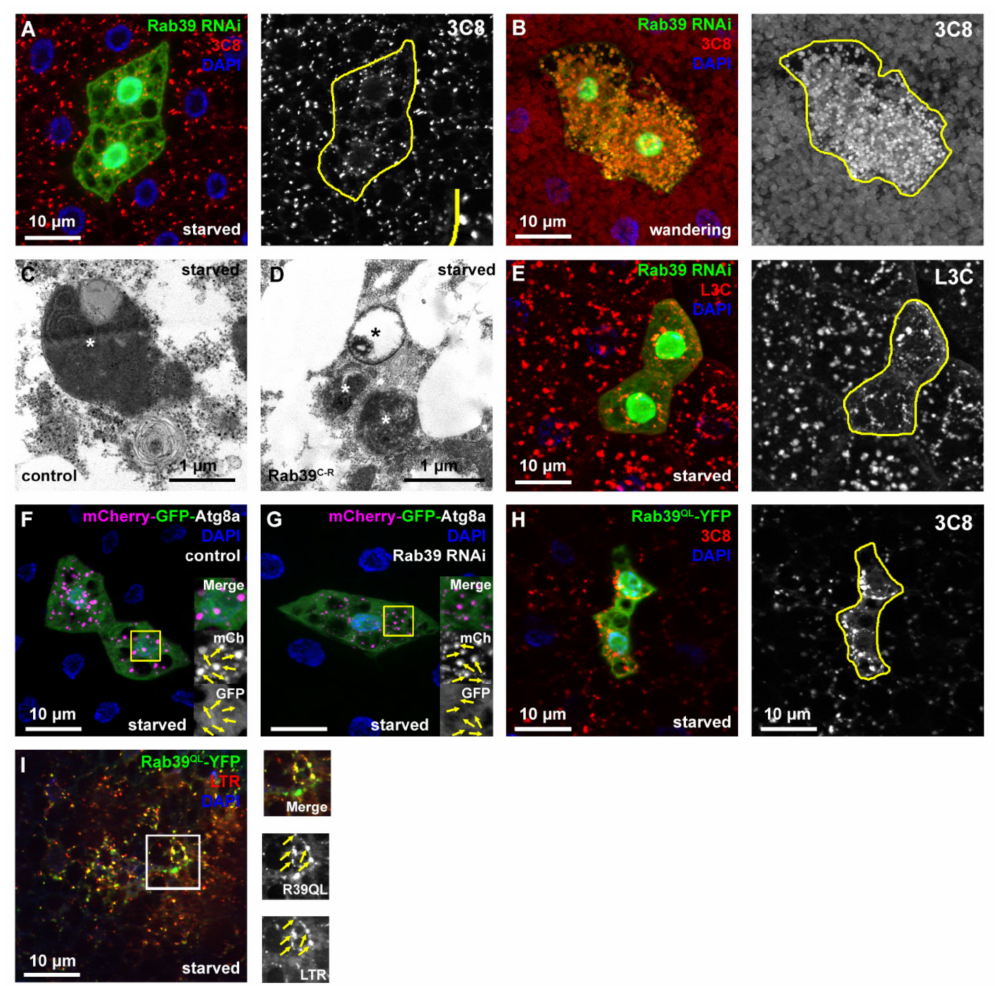
Figure 4. Rab39 accelerates autophagic degradation in fat cells. ( A , B ) 3xmCherry-Atg8a was expressed in all fat cells in starved ( A ) or wandering ( B ) L3 stage animals. In the GFP-positive cells, Rab39 was silenced with RNAi (marked with yellow line in the grayscale panels). In both cases, 3xmCherry-Atg8a dots were smaller in the GFP-positive cells compared to the adjacent control cells. ( A ) An inset shows the size difference of 3xmCherry-Atg8 dots. ( C , D ) Representative electron micrographs of autolysosomes (marked with asterisks) from control ( C ) and Rab39 mutant ( D ) starved fat cells of L3 stage wandering larvae. The mutant cells contain smaller yet degrading, functional autolysosomes (i.e., no intact organelles are visible within the autolysosome), and also no autophagosome accumulation is observed. ( E ) dLAMP-3xmCherry expressing fat body tissue from starved L3 stage larvae: Rab39 RNAi cells (marked with GFP) contain smaller dLAMP-3xmCherry dots than the neighboring control cells. ( F , G ) mCherry-GFP-Atg8a with ( G ) or without ( F ) Rab39 RNAi was expressed in several cells in fat tissues of L3 stage starved larvae. Magenta alone depicts autolysosomes (marked by arrows), as GFP is quenched in acidic environment. Please note that the difference in nuclei size is the result of rapid nuclei size change due to development and it does not affect autophagic flux. ( H ) Rab39 QL -YFP was expressed in cell clones, while 3xmCherry-Atg8a reporter was expressed throughout the fat body tissue of L3 stage starved larvae. By expressing the constitutively active form of Rab39 in an ectopic manner, large mCherry-positive vesicles appeared. ( I ) Colocalization experiment in L3 stage starved larvae of Rab39 QL -YFP and LTR shows a marginal overlap between the two signals, suggesting an autolysosomal Rab39 localization. Boxed regions are enlarged in ( F , G , I ) and colocalizing signals are marked by arrows. Heterozygous Rab39 C-R animals with ( F ) or without ( C ) the indicated transgenes were used as